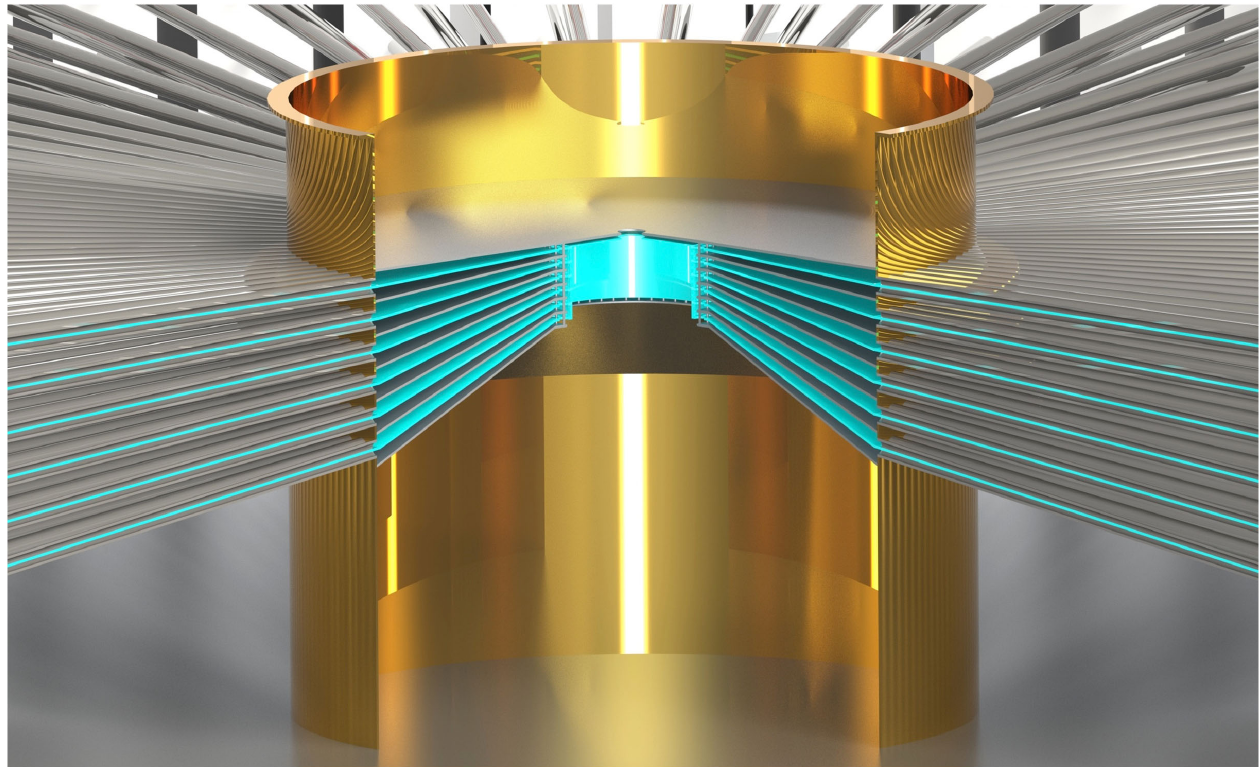
FIG. 4. Cross-sectional view of Neptune ’ s six-level conical-transmission-line system and post-hole convolute.